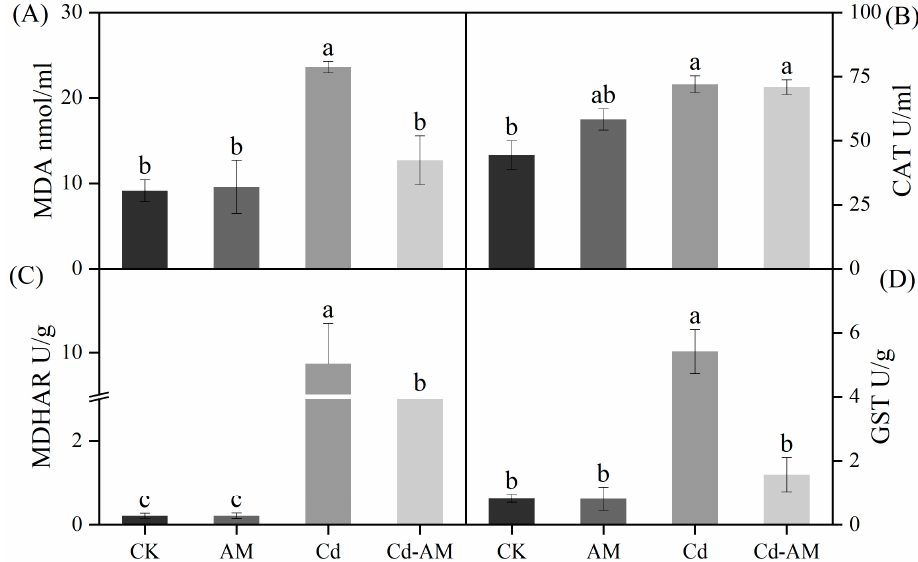
Figure 3. M. truncatula leaf malondialdehyde (MDA) ( A ), catalase (CAT) ( B ), monodehydroascorbate reductase (MDHAR) ( C ), and glutathione sulfhydryltransferase (GST) ( D ) activities under different treatments. Values are expressed as means ± SE ( n = 3). Values followed by the same letter in the same column are not significantly different ( p < 0.05).